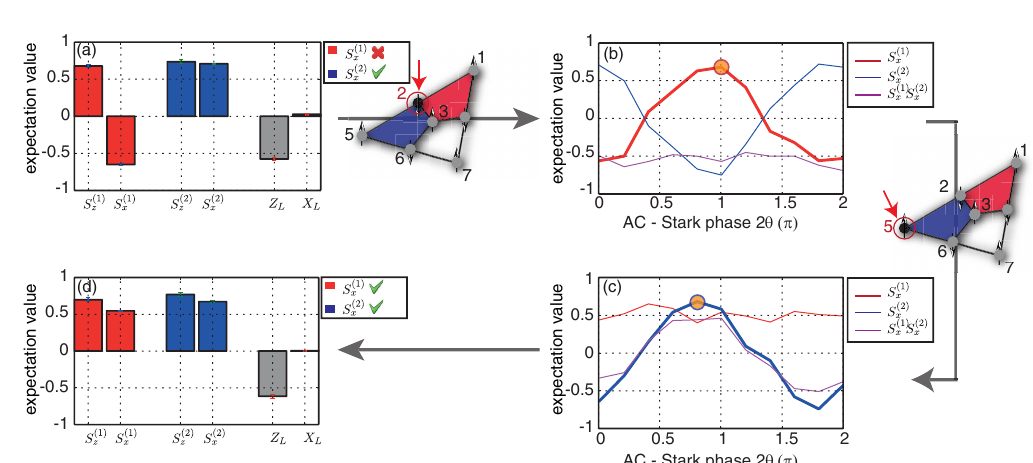
FIG. 2. Experimental implementation of the phase optimization protocol. Here, the algorithm was applied to the intermediate state in the encoding sequence, which results from the application of the first two entangling operations acting on the qubits of the first (red) and second (blue) plaquettes of the planar seven-qubit quantum error correcting code. The resulting state (a), before the application of the iterative phase optimization technique, is characterized by positive values of Z -type plaquette stabilizer expectation values, which are maximal within the experimentally achieved accuracy of the encoding circuit [16]. On the other hand, X -type stabilizer expectation values have arbitrary values (positive on the first, negative on the second plaquette), indicating the presence of undesired, unknown relative phase shifts [see Eq. (6)]. In the first step of phase optimization (b), a Z rotation of variable magnitude is applied to qubit 2, 1 Þ ð 2 Þ which results in a sinusoidal behavior of the expectation values of the stabilizers h S ð x i and h S x i [cf. Eqs. (8) and (9)], whereas the 1 Þ ð 2 Þ expectation value h S ð x S x i not containing X 2 remains constant. For each scan, the stabilizer that takes part in the optimization procedure is highlighted by the bold line, and the corresponding maximum value is marked via the orange circle. After reading off and fixing θ 2 to 1 Þ Z rotation is applied to qubit 5 (c). This scan is used to fix θ the value that maximizes h S ð x i (orange circle), a 5 to the value that 2 Þ ð 1 Þ ð 2 Þ maximizes h S ð x i . Whereas, in principle, at this point one would proceed with the optimization of h S x S x i by a Z 1 -rotation scan, the data show that all three stabilizers, within experimental resolution, have already reached the maximum, indicating convergence of the protocol. This is also reflected by both X -type plaquette stabilizers now being positive and maximal (d), while the expectation values of Z -type stabilizers and of the logical Z operator have remained unchanged over the application of the algorithm — compare (a) and (d). Experimental parameters: In each scan, different values for the phases characterizing the single-qubit rotations were applied with an elementary step size of 2 π = 10 . For each phase value, the experiment was repeated 200